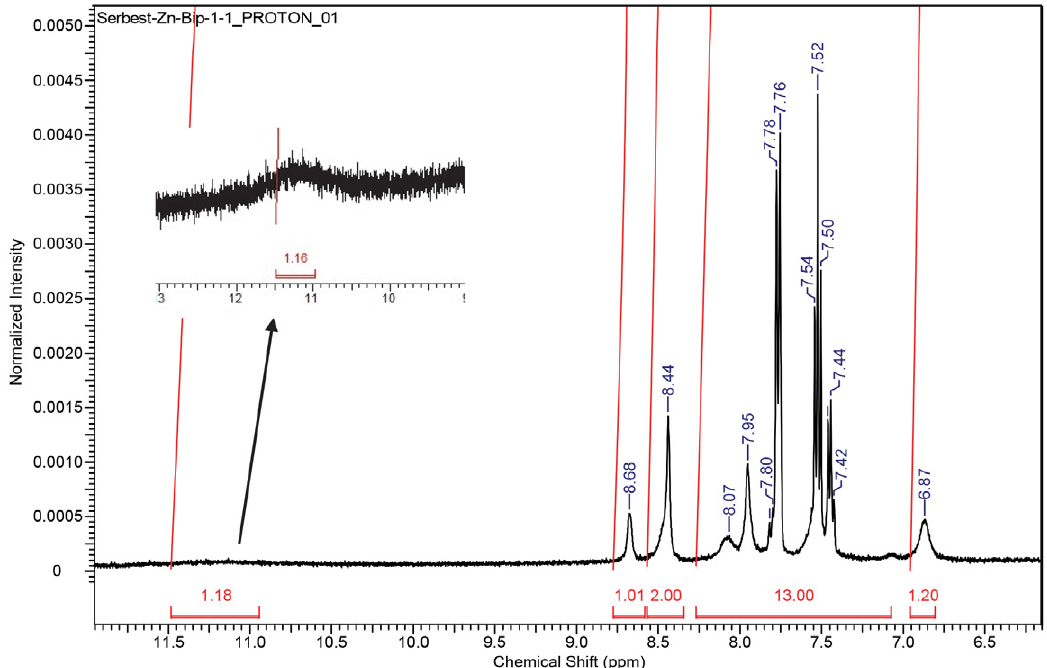
Figure 2: 1 H NMR spectra of Zn(II) complex, 5 in DMSO-d 6